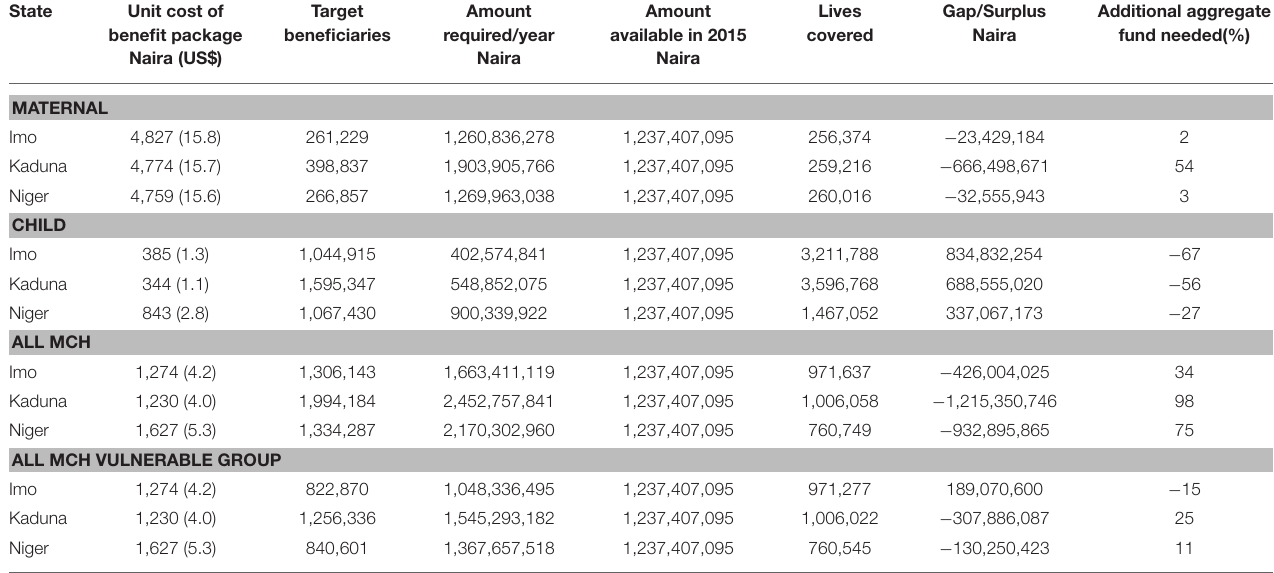
TABLE 9 | Scenario: 1f (Revenue: 95% of BHCPF plus counterpart fund (0.25 of 95%).